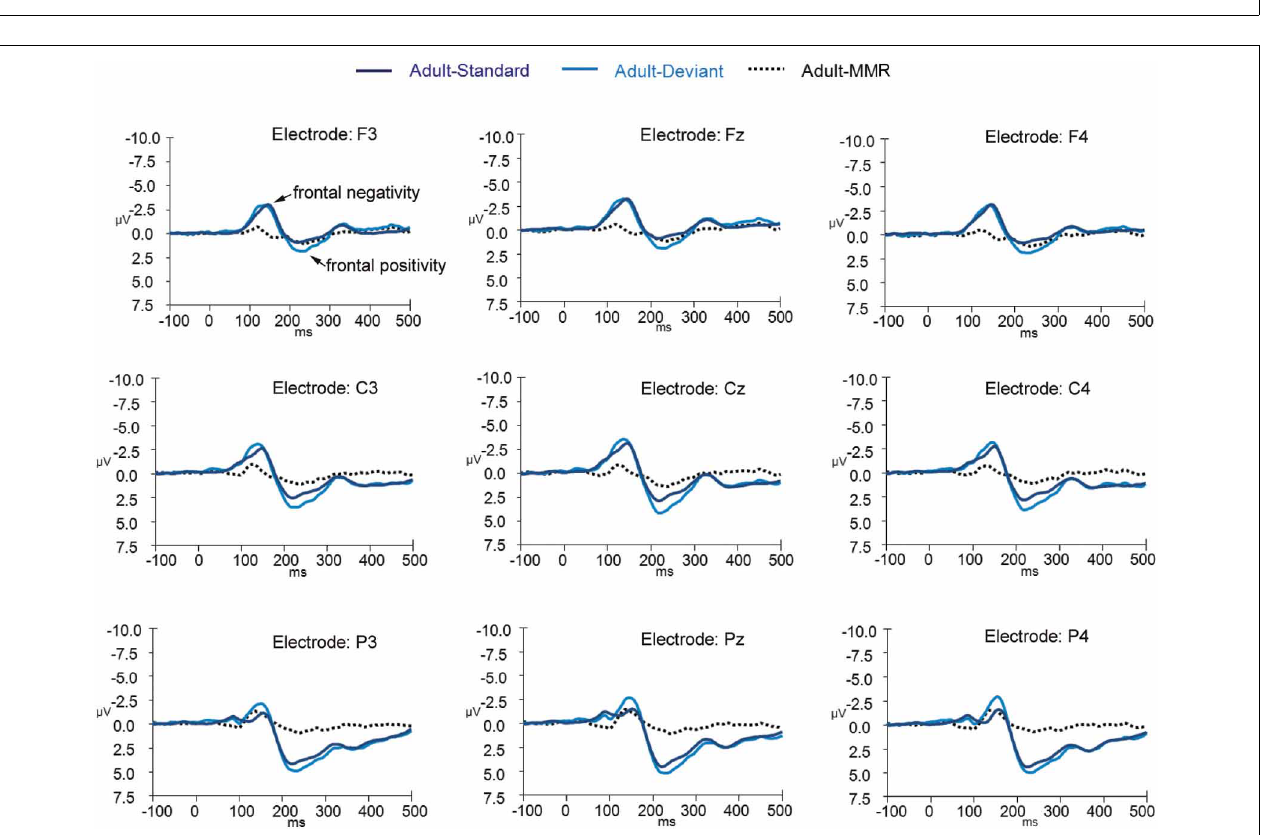
Frontiers in Human Neuroscience